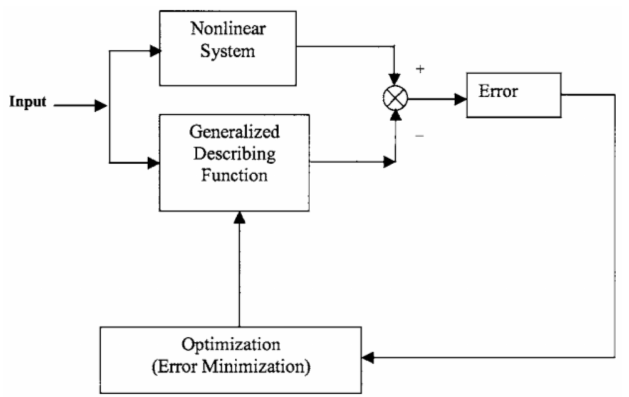
Figure 13. The schematic of novel generalized describing function (NGDF) for modeling jet en- gines [38]